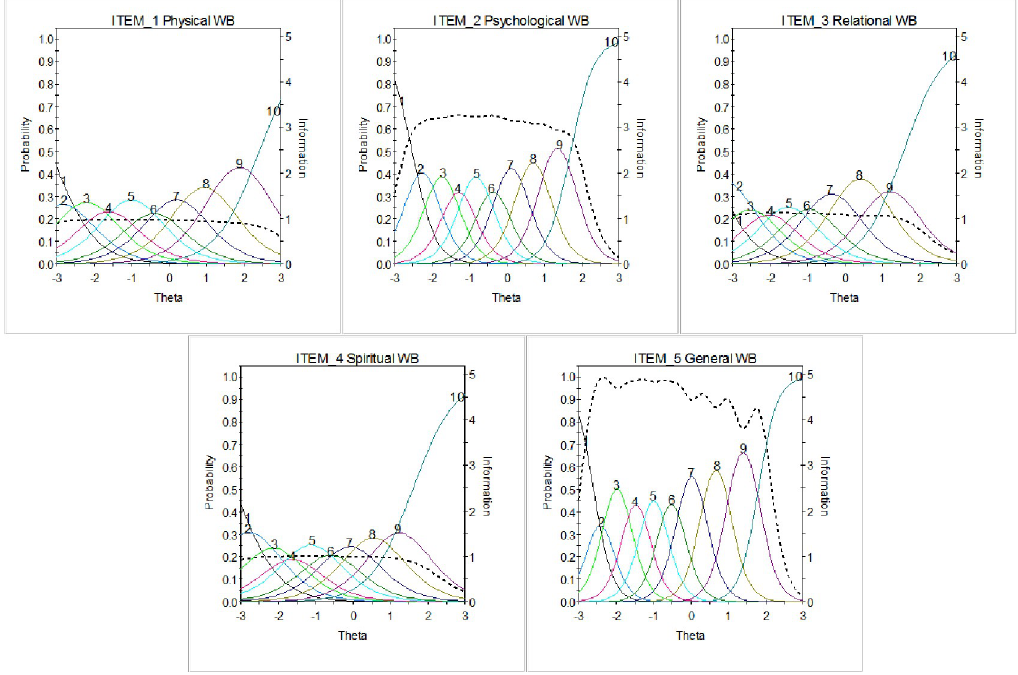
Fig 2. Item Characteristic Curve (ICC) and Item Information Function (IIF) of the 5 items of the Well-being Numerical Rating Scales (WB-NRSs). Latent trait (Theta) is shown on the horizontal axis, the probability of endorsing a response option (solid line) is shown on the left vertical axis, and the amount of information (dotted line) yielded by the item at each trait level is shown on the right vertical